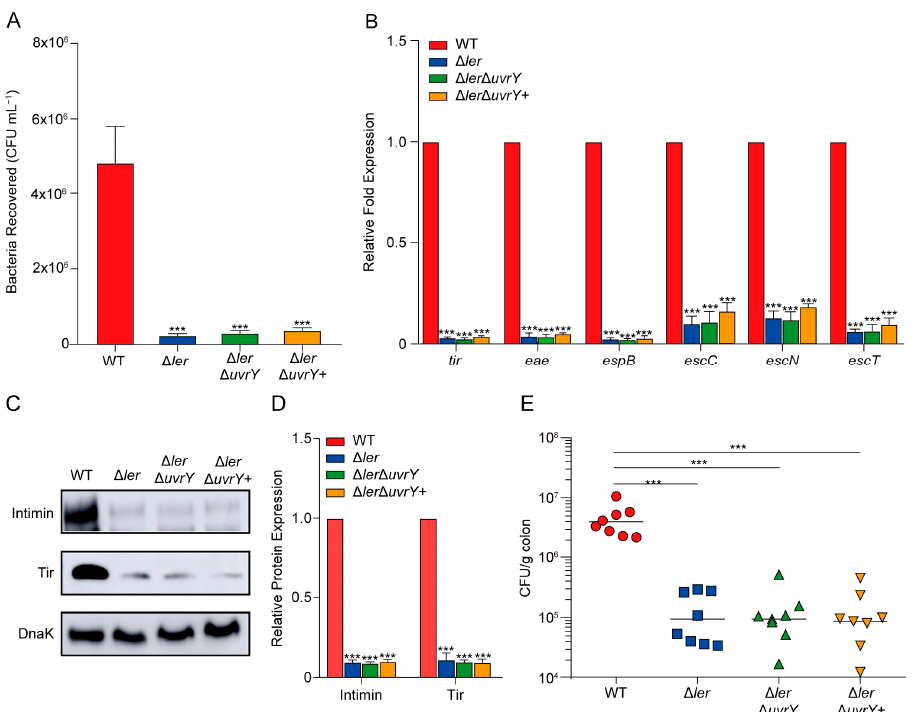
Figure 3. UvrY activates LEE gene expression via ler . ( A ) A bar plot showing the adherence level of WT, ∆ ler , ∆ ler ∆ uvrY , and ∆ ler ∆ uvrY + strains to HeLa cells (n = 3). ( B ) A bar plot showing the qRT-PCR expression quantification level of the representative LEE genes in WT, ∆ ler , ∆ ler ∆ uvrY , and ∆ ler ∆ uvrY + strains ( n = 3). ( C ) Western blot analysis of intimin and Tir in WT, ∆ ler , ∆ ler ∆ uvrY , and ∆ ler ∆ uvrY + strains cultured in DMEM for 3 h. DnaK was loaded as a quantification control. ( D ) A bar plot showing the quantification level of proteins in ( C ), performed in ImageJ. Three independent experiments were performed for the Western blot analysis. Significance was determined using two- tailed unpaired Student’s t -test ( A , B , D ). *** represents p ≤ 0.001; n.s. represents no significant dif- ference. ( E ) A scatter plot showing the mice colonization bacteria CFU numbers after inoculation with WT, Δ ler , Δ ler Δ uvrY , and Δ ler Δ uvrY + at 6 h post-infection ( n = 8). For each group, eight BALB/c mice were utilized. Significance was determined using Mann–Whitney rank-sum test. *** represents p ≤ 0.001; n.s. represents no significant difference.